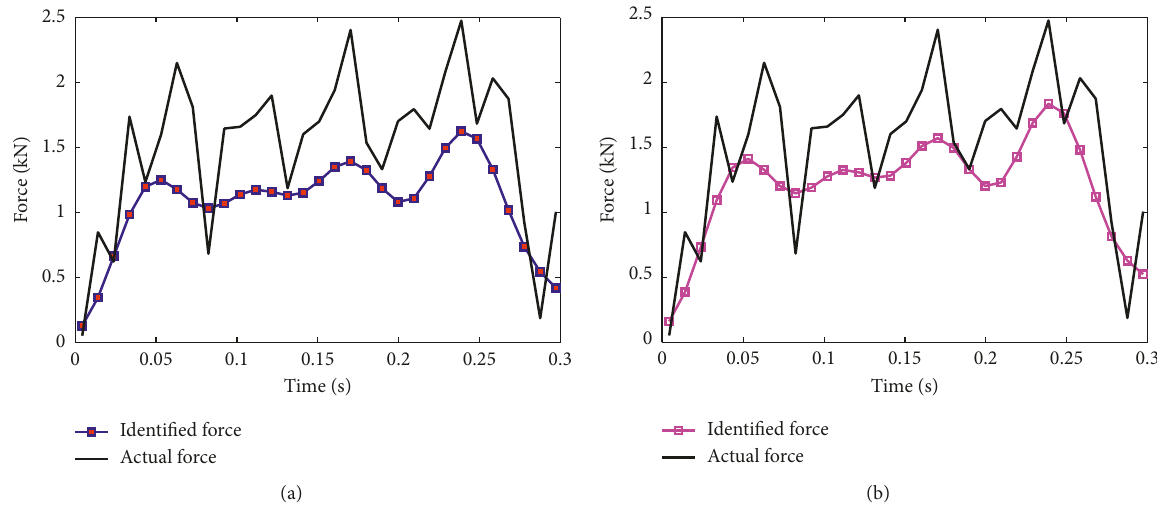
Figure 6: Different identification techniques using L-curve: (a) MER technique and (b) IMER technique.